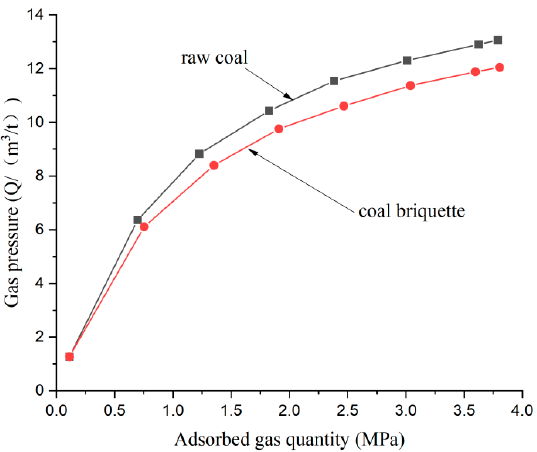
Figure 9. Comparison between gas adsorption of coal and the similar material.